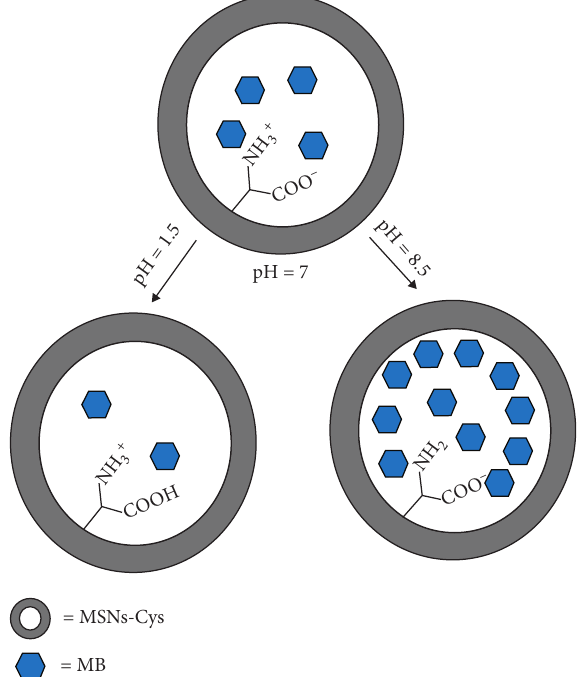
Figure 5: Schematic representation of the suggested adsorption mechanism of MB onto